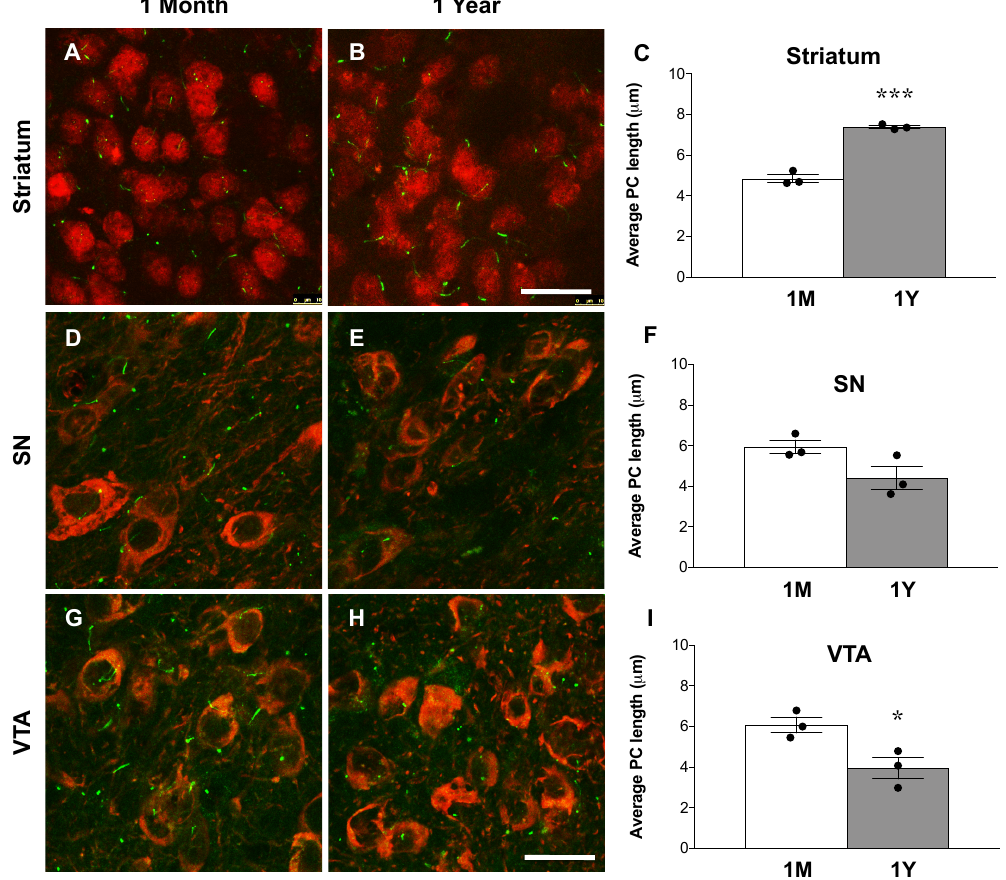
Figure 6. The length of PC increases during aging in striatal neurons of wildtype mice, but not in DA neurons. Figure 6 ( A , B , D – H ) Representative confocal images of coronal sections showing ACIII in striatal and SN and VTA DA neurons by immunofluorescence with an ACIII-specific antibody (green) and a TH-specific antibody (red) at 1 month and at 1 year. Quantification of the average PC length in striatal neurons of control mice ( C ) and in SN and VTA DA neurons ( F , I ) at 1 month and 1 year. At least 80 cilia from each mouse were measured ( n = 3 per group). The data are presented as the mean ± SEM. Statistical significance between the indicated groups was determined by unpaired two-tailed Student’s t -test; * p < 0.05, *** p < 0.0005 (for details, see also supplementary statistical information). Scale bars: ( A , C ): 25 µ m; ( B , D ): 50 µ